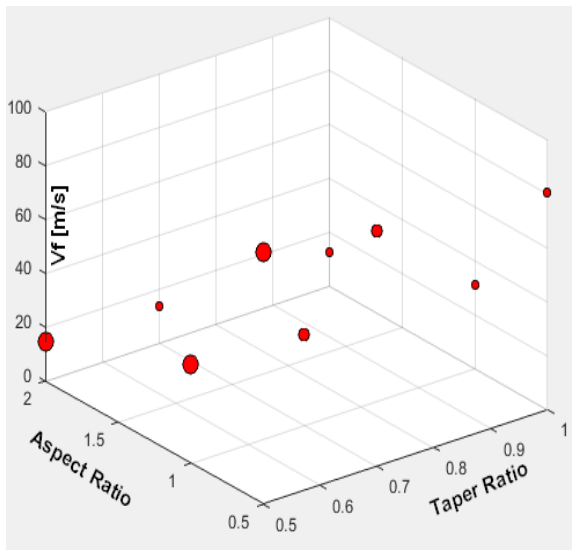
Figure 10. Flutter velocity as a function of Aspect and Taper Ratio Analyzing the results obtained, it was observed that increasing the aspect ratio lowers the flutter velocities; however, it increases overall stability. For lower to moderate Aspect ratios, the taper ratio does not significantly influence flutter speeds (Figure 11). For low ratios, flutter speeds are the maximum for a particular configuration. Flutter models used render similar results for moderate